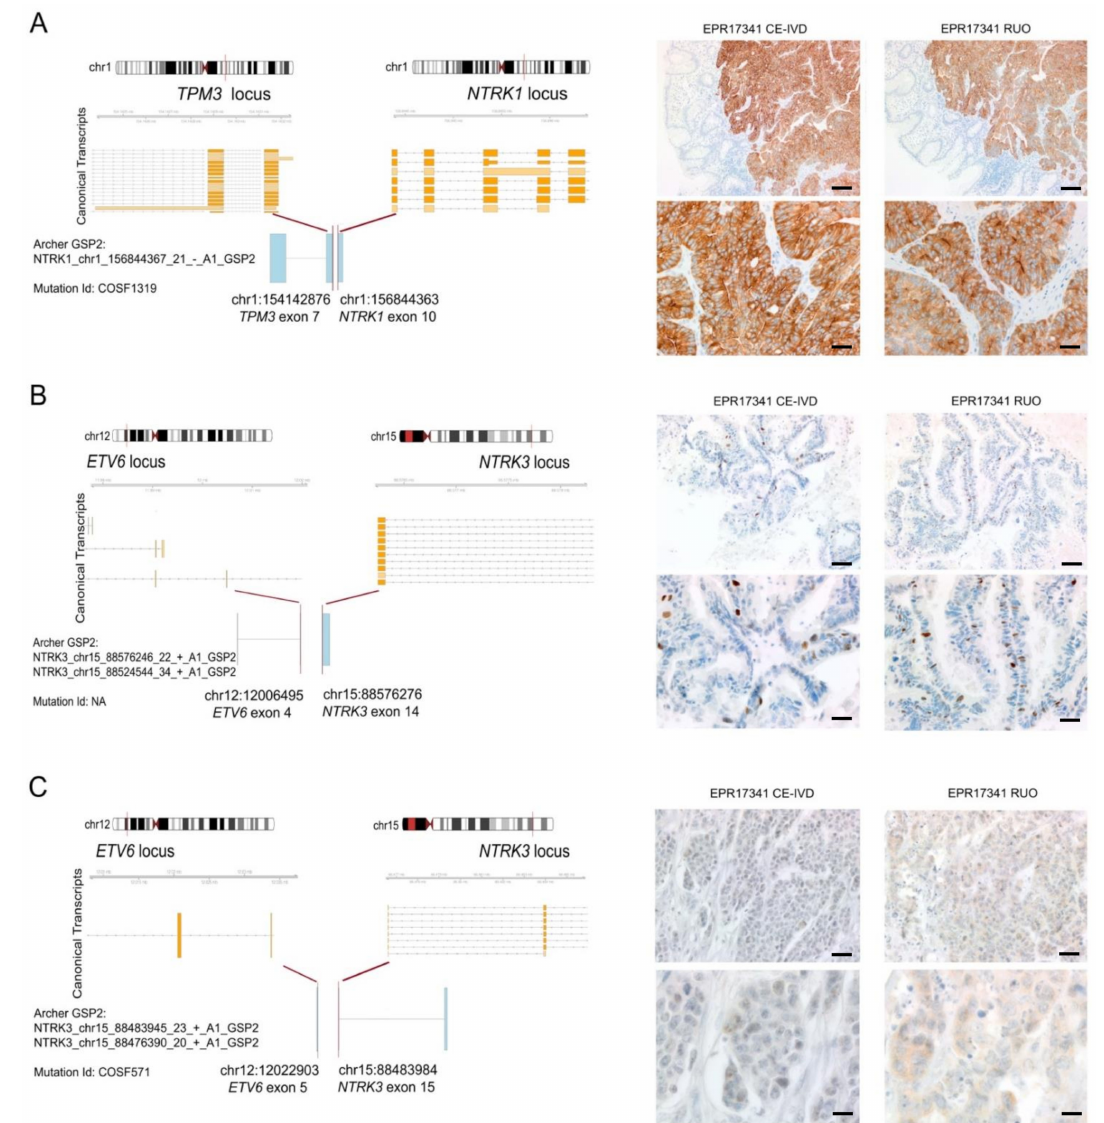
Figure 4. Summary of the detected fusion events involving NTRK genes. Each panel consists of a schematic three-tier representation of the fusion identified by the NGS assay and the two pan-TRK antibody IHC stainings. The fusion point is identified by a red bar at the chromosomal loci. Below the chromosomal ideograms, the canonical transcripts reported by Ensembl (release 103) illustrate the transcriptional context of the involved genes (exons are indicated by orange boxes and introns are indicated by grey arrow-headed lines). Each row is a different isoform of the transcript reported by Ensembl. At the bottom, the fusion points between the Archer sequenced exons (blue boxes) and the exact chromosomal position of the breakpoint are reported. ( A ) Representation of the fusion between TPM3 and NTRK1 genes. The illustration reports the rearrangement breakpoint, the Archer panel technical output confirming the fusion, and the COSMIC ID. Representative micrographs of the CRC sample harbouring the fusion show a diffuse cytoplasmic expression with focal membranous linear patterns in the experiments run with both CE-IVD and RUO assays (scale bars: top panels, 100 µ m; bottom panels, 50 µ m). ( B ) Representation of the fusion between the ETV6 ex4 and NTRK3 ex14 genes. The illustration reports the rearrangement breakpoint, the Archer panel technical output confirming the fusion, and the COSMIC ID. IHC images highlight the presence of a subpopulation of tumour cells of the LAC with papillary features displaying an intense nuclear expression, as demonstrated by both assays (scale bars: top panels, 100 µ m; bottom panels, 50 µ m). ( C ) Representation of the fusion between ETV6 ex5 and NTRK3 ex15 genes. The illustration reports the rearrangement breakpoint, the Archer panel technical output confirming the fusion, and the COSMIC ID. A weak cytoplasmic expression is present in this CRC in both experiments, with the RUO assay showing a slightly more granular staining (scale bars: top panels, 50 µ m; bottom panels, 25 µ